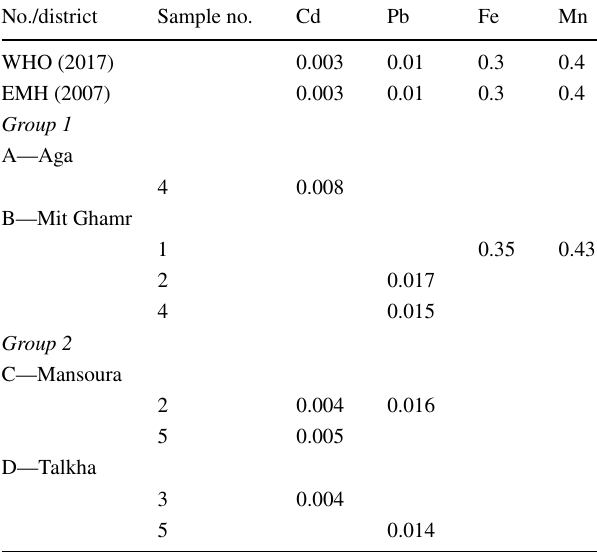
Table 2 High levels of heavy metals in water samples No./district